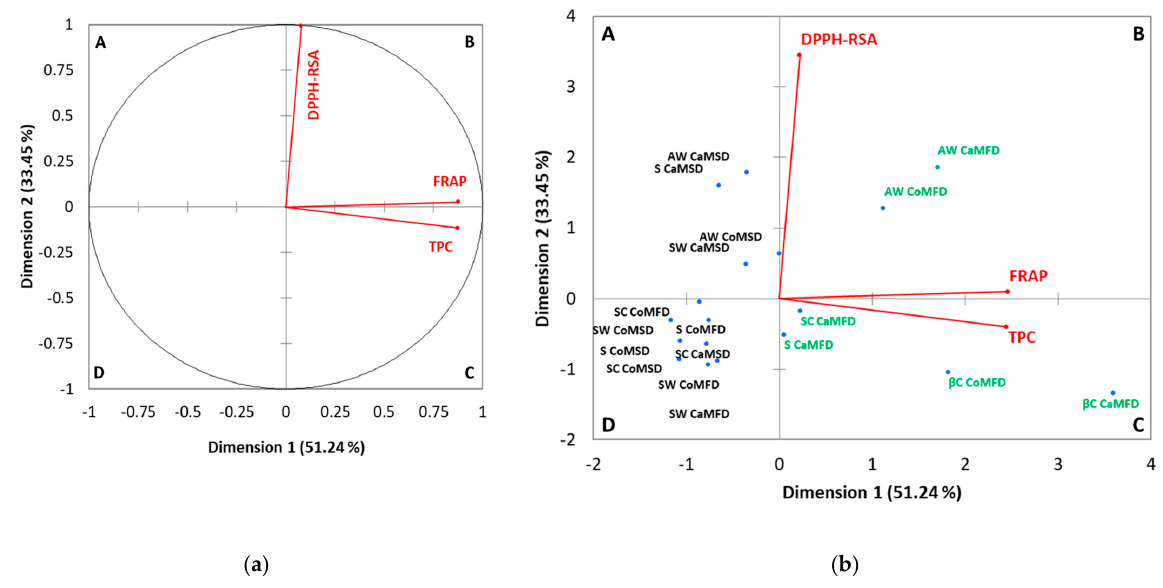
Figure 5. PCA biplot of objects and component loads for the grouping of descriptors for bioactive contents (TPC, DPPH- and FRAP assays) ( a ) and groups of milk fraction samples ( b ). S CoM: skim cow milk; AWCoM: acid whey from cow milk; SW CoM: sweet whey from cow milk; SC CoM: sodium caseinate, from cow milk; β C CoM: β -casein from cow milk; S CaM: skim camel milk; AW CaM: acid whey from camel milk; SW CaM: sweet whey from camel milk; SC CaM: sodium caseinate, from camel milk; β C CaM: β -casein from camel milk. FD: freeze-dried; SD: spray-dried. A-D are the quadrants of the PCA biplot.